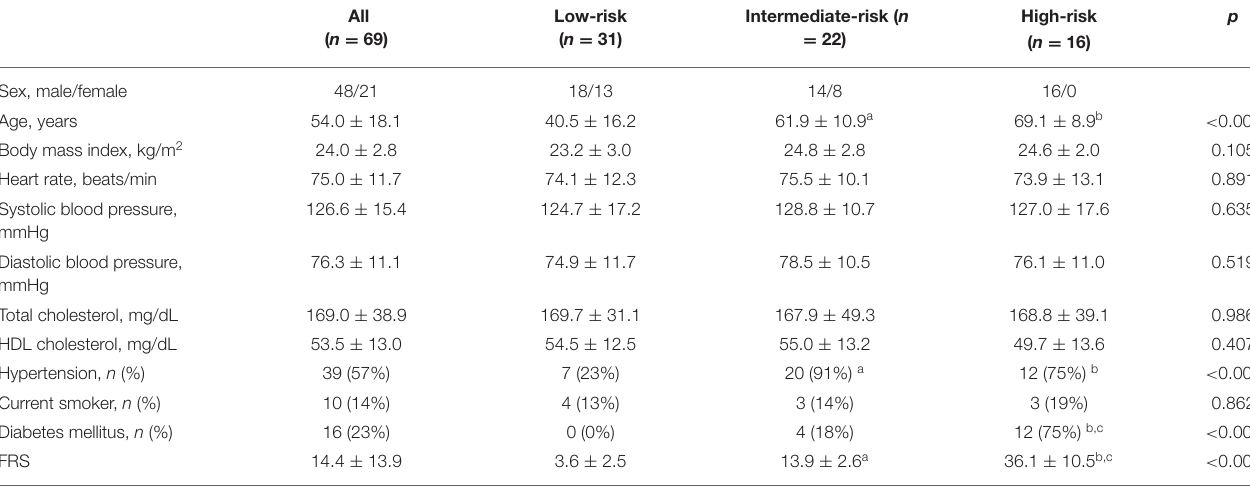
TABLE 1 | Baseline characteristics and measurements of the study population ( n = 69) classified by Framingham risk